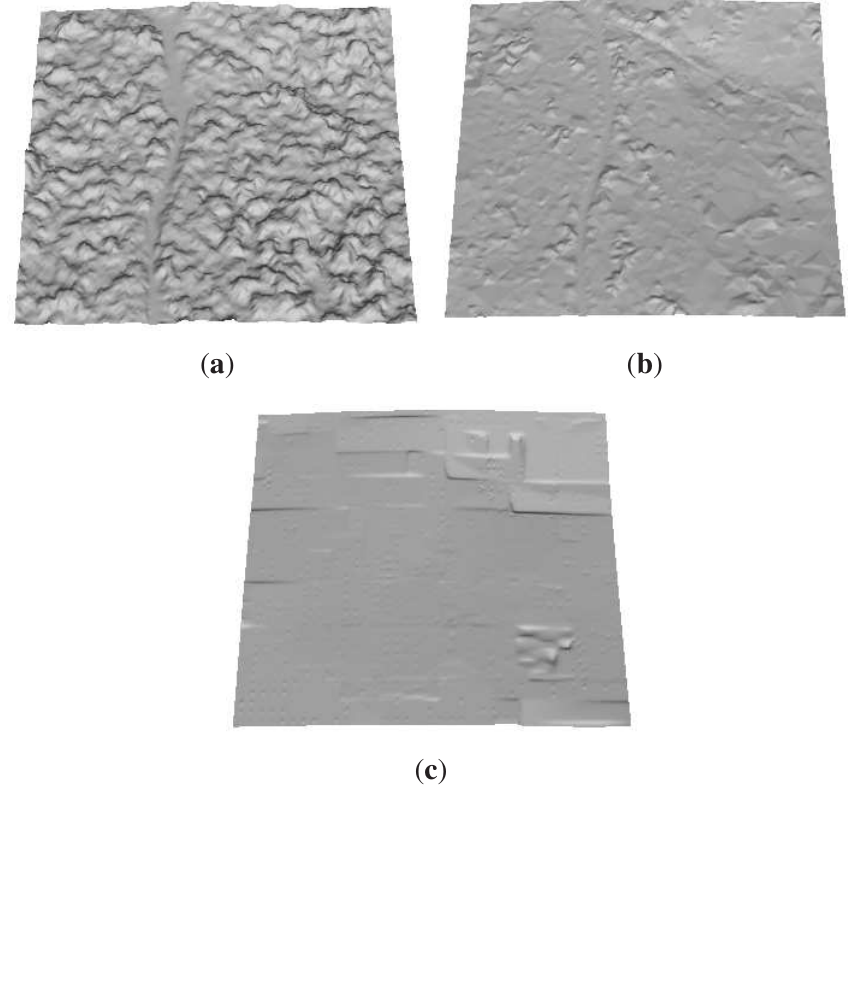
Figure 12. Comparing DTMs produced by (a) Karl Kraus (KK), (b) Peter Axelsson (PA) and (c) Maguya Almasi (MA) at Site 3. The width of the DTM section is approximately 400 m. (d) Difference model: KK − MA ; (e) Difference model: P A − MA